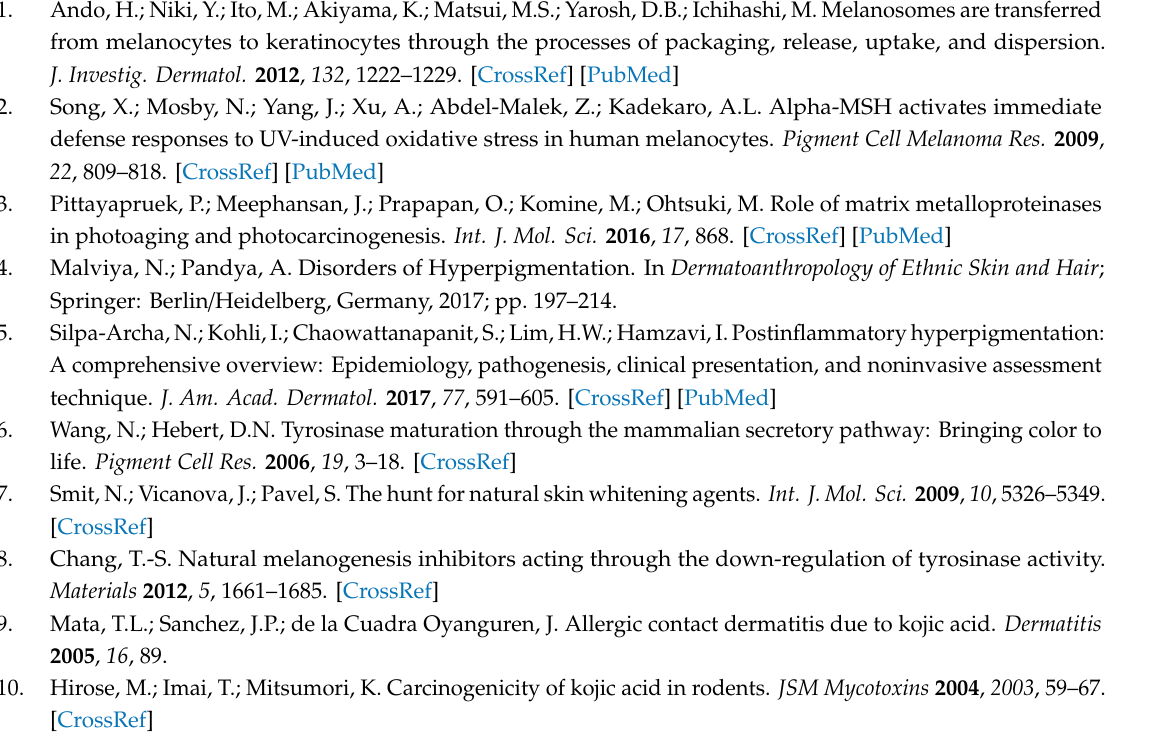
Figure S1. MITF protein levels in B16F10 cells treated with TR (25 µ M) under (A) Basal and (B) α -MSH-stimulated conditions. Figure S2. Viability of HaCaT cells treated with TR (5–25 µ M) for 72